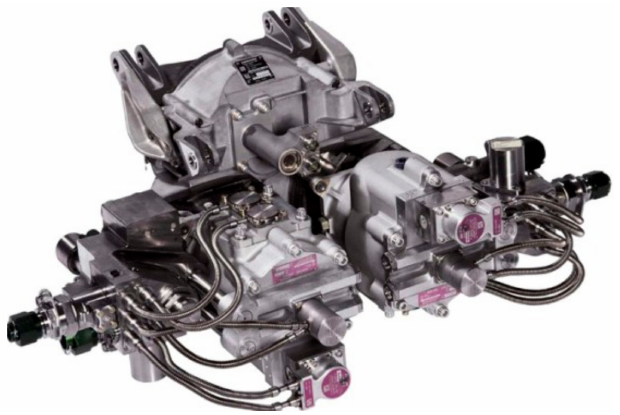
Figure 4. A power-control unit (PCU) as an integral part of the